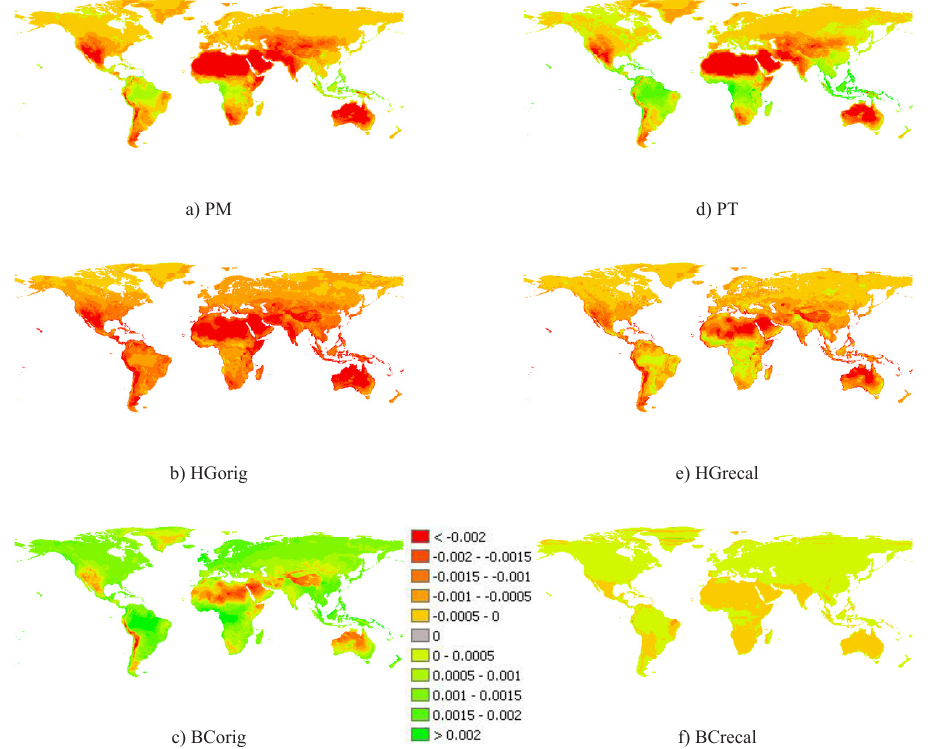
Fig. 3. Global maps with annual average bias of CFSR estimated daily reference potential evaporation (PET; mday − 1 ) from annual average CRU Penman-Monteith reference PET. In the left column bias in PET obtained with the Penman-Monteith (PM), the standard Hargreaves (HGorig) and Blaney-Criddle (BCorig) method are displayed. In the right column bias obtained with Priestley-Taylor (PT), Hargreaves with increased multiplication factor (HGrecal) and the re-calibrated Blaney-Criddle equation (BCrecal) are